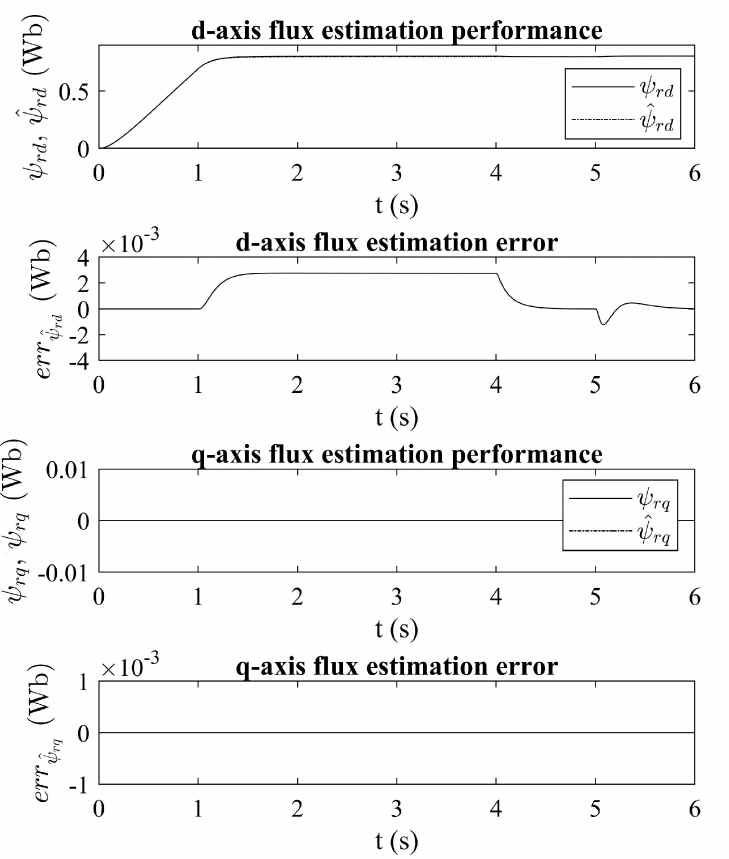
Figure 6. Estimated rotor flux components and estimation errors.